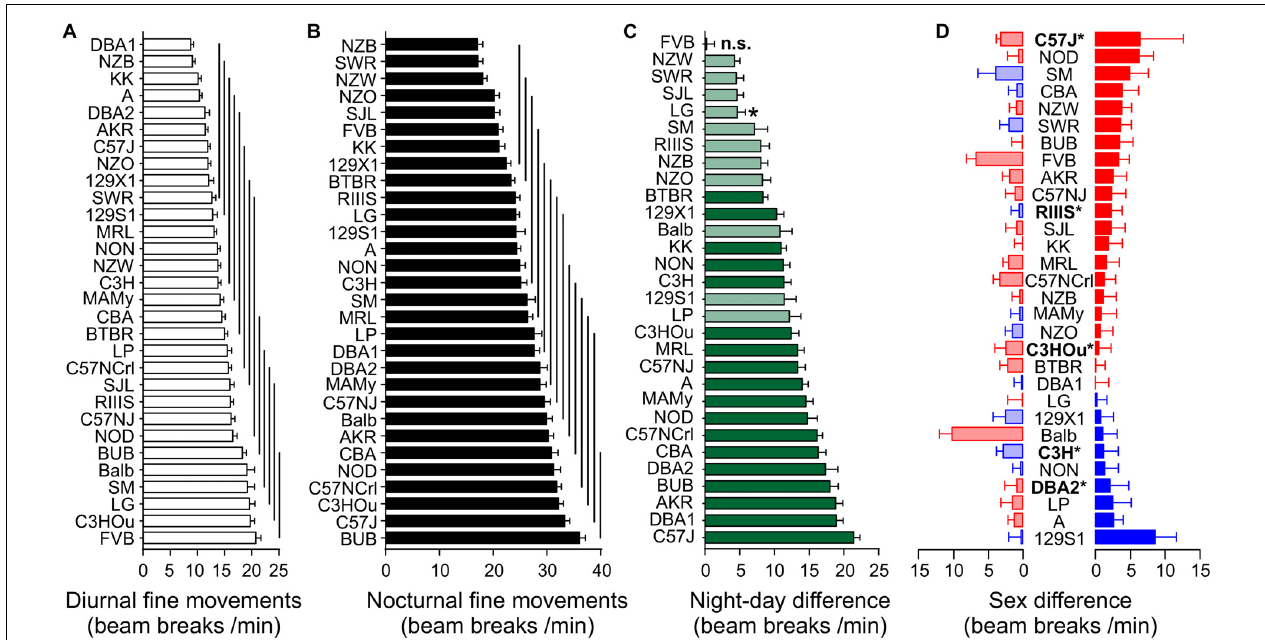
FIGURE 3 | Strain, day–night and sex differences of fine movements. Strain-dependence of diurnal (A) and nocturnal (B) fine movements. The values are presented as mean ± SEM, averaged from both sexes. The vertical lines connect groups with homogenous means according to Tukey’s post hoc test. (C) Day–night differences were ranked and Cohen’s D calculated. Significant differences at p < 0.0016 are indicated with asterisk and p -levels < 0.001 were not marked; “n.s.” not significant. The effect sizes ranged from D = 0.80 (LG) to D = 4.96 (C57J) and are indicated in light green ( D = 0.8 and D < 2) and dark green ( D ≥ 2). (D) Sex differences in fine-motor behavior were apparent in five strains at p < 0.05. The strains are ranked from largest to smallest sex difference for the scotophase, beginning, at the top, with strains, where females (red) were more active than males, while blue columns illustrate strains with more active males. To the left, nocturnal values are associated with the respective diurnal values and are displayed in light colors. All values are displayed as means ± standard error of the difference. Asterisks and bold font indicate significant sex differences, * p <